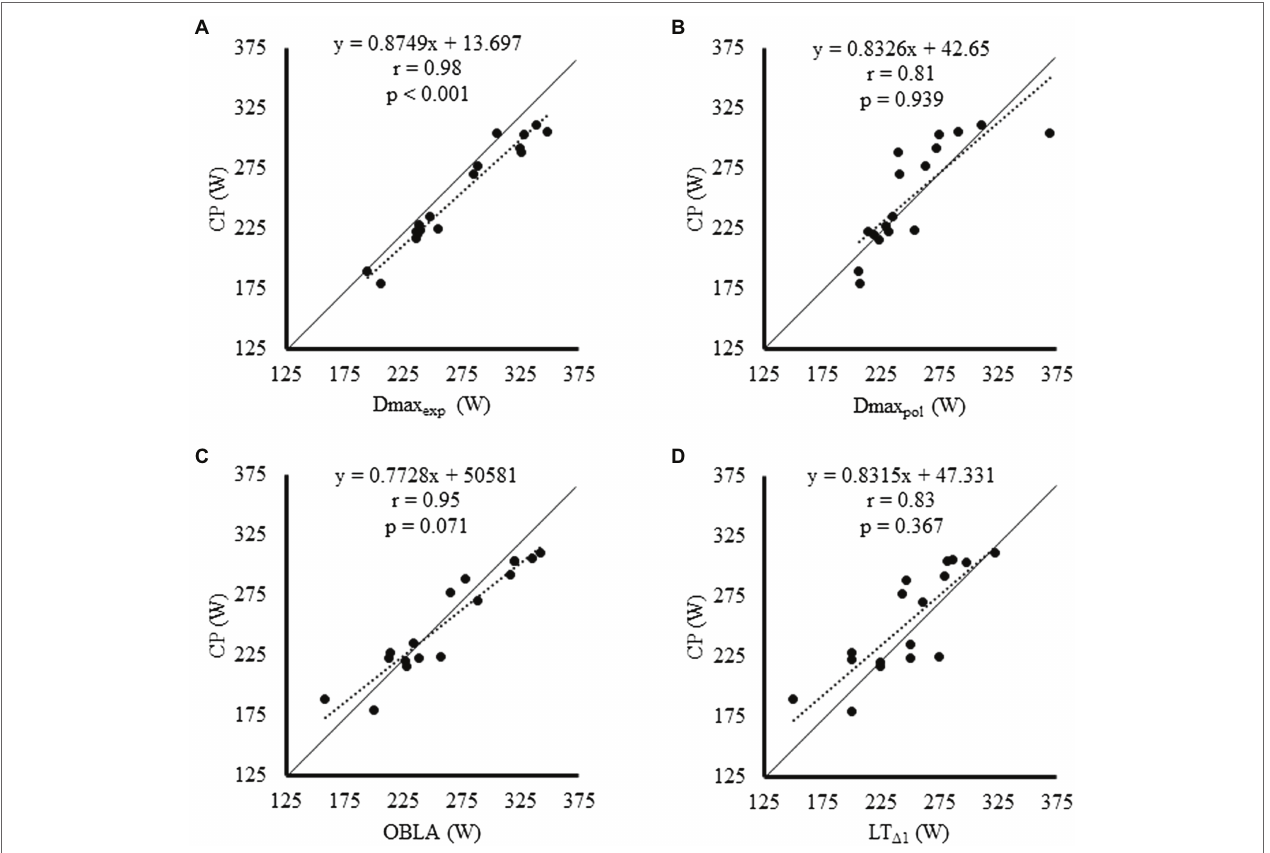
FIGURE 2 | Relationship between each lactate threshold marker [Dmax exp (A) , Dmax pol (B) , OBLA (C) , and LT lactate